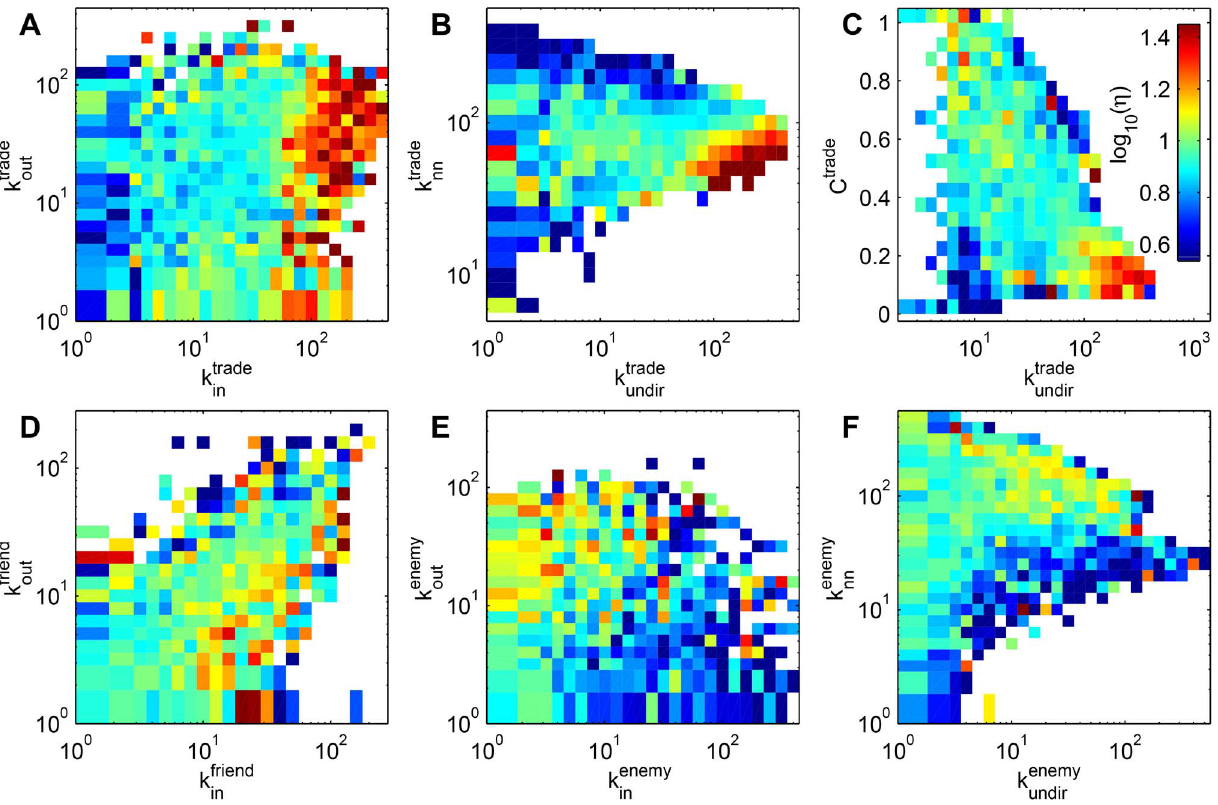
Figure 8. Wealth-gain as a function of network properties. Color represents the logarithm of the wealth-gain, log 10 ( g ) , from blue (lowest) to red (highest), empty bins are white. A trade in- and out-degree, B trade undirected degree and nearest-neighbor degree, C trade undirected degree and clustering coefficient, D friend in- and out-degree, E enmity in- and out-degree, F enmity undirected degree and nearest-neighbor degree. Data are taken every 240 days (see Methods).